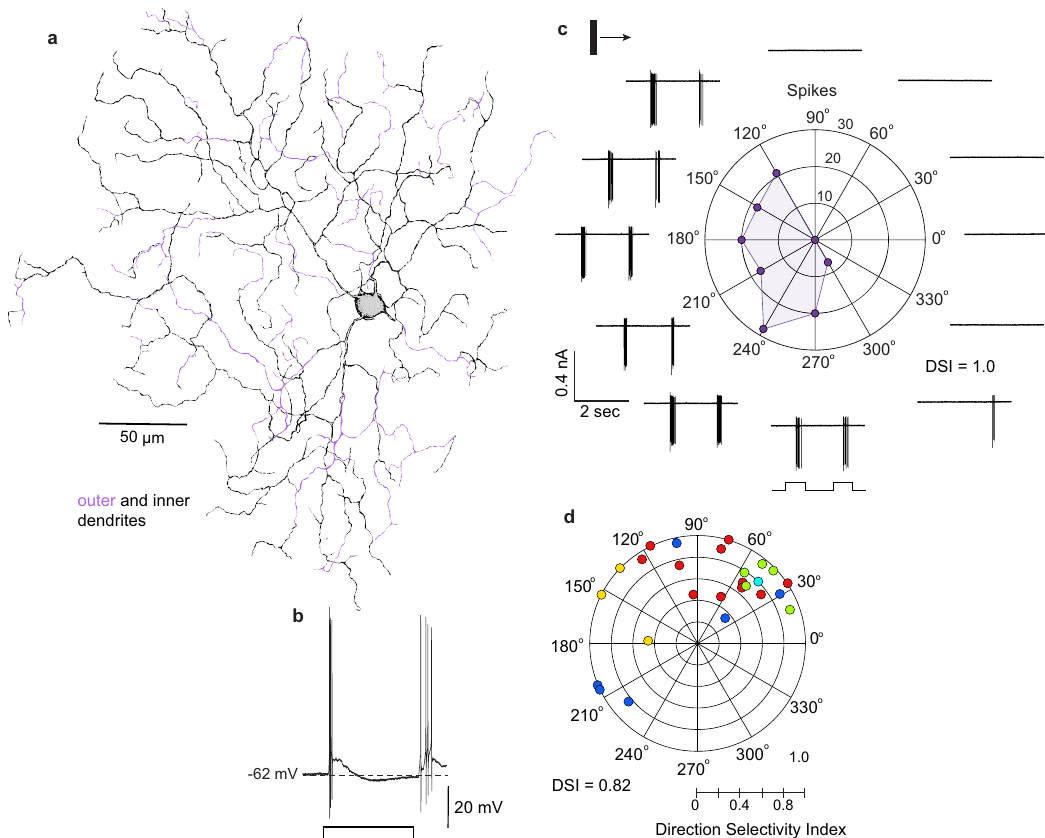
Fig. 3 The recursive bistrati fi ed ganglion cell is an ON – OFF direction-selective type. a Dendritic morphology of a recursive bistrati fi ed ganglion cell in macaque retina retrogradely labeled and photostained in vitro after rhodamine dextran tracer injections in the LGN. b ON – OFF response evoked by a Fig. 4 for details). c Polar plot of extracellularly recorded spike activity evoked by a bar of light (100 µ m width, 600 µ m height) moving (2000 µ m/s) across the cell ’ s receptive fi eld. Spikes were summed from separate bursts of spikes evoked by 2 sweeps of the bar stimulus. d Plot showing Direction Selectivity Index (DSI) and preferred direction of spike activity evoked by a moving bar in 26 recursive bistrati fi ed ganglion cells extracellularly recorded from 5 different (color coded) retrogradely labeled retinas. The mean DSI ± s.d. of this data set was 0.82± 0.20 ( n = 26). The stimulus parameters (bar dimensions, velocity, and contrast) were not standardized across all experiments, which may contribute to the cell-to-cell differences in